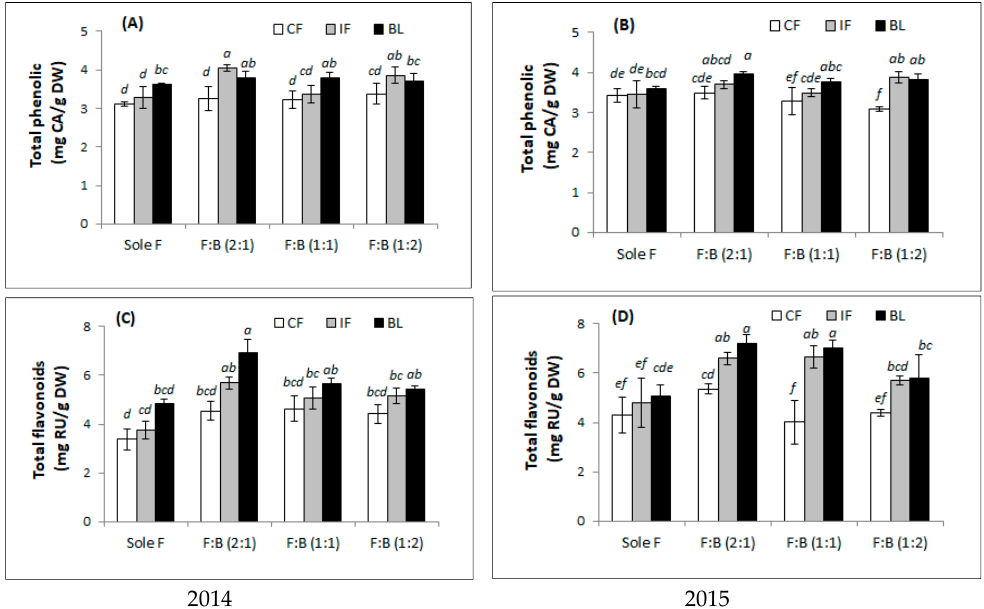
Figure 3. Total phenolic content ( A and B ) and total flavonoids content ( C and D ) of fenugreek seeds as affected by cropping system × fertilizer type interaction in 2014 and 2015. Different letters indicate significant differences at p < 0.05 by LSD test. See Figure 2 for treatments.